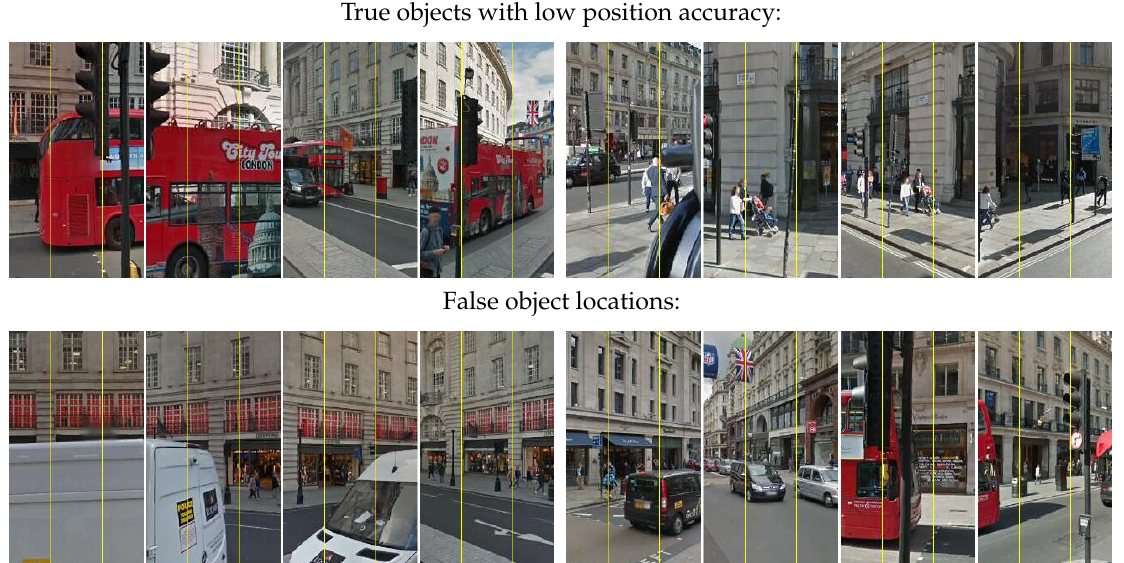
Figure 5. Multiple views of detected traffic lights positions: each observed from four distinct GSV camera locations with view headings calculated based on the camera’s and estimated object’s coordinates. The field of view in each of four image comprising multi-view panel is 25 ◦ , of which the central 10 ◦ are between the yellow vertical